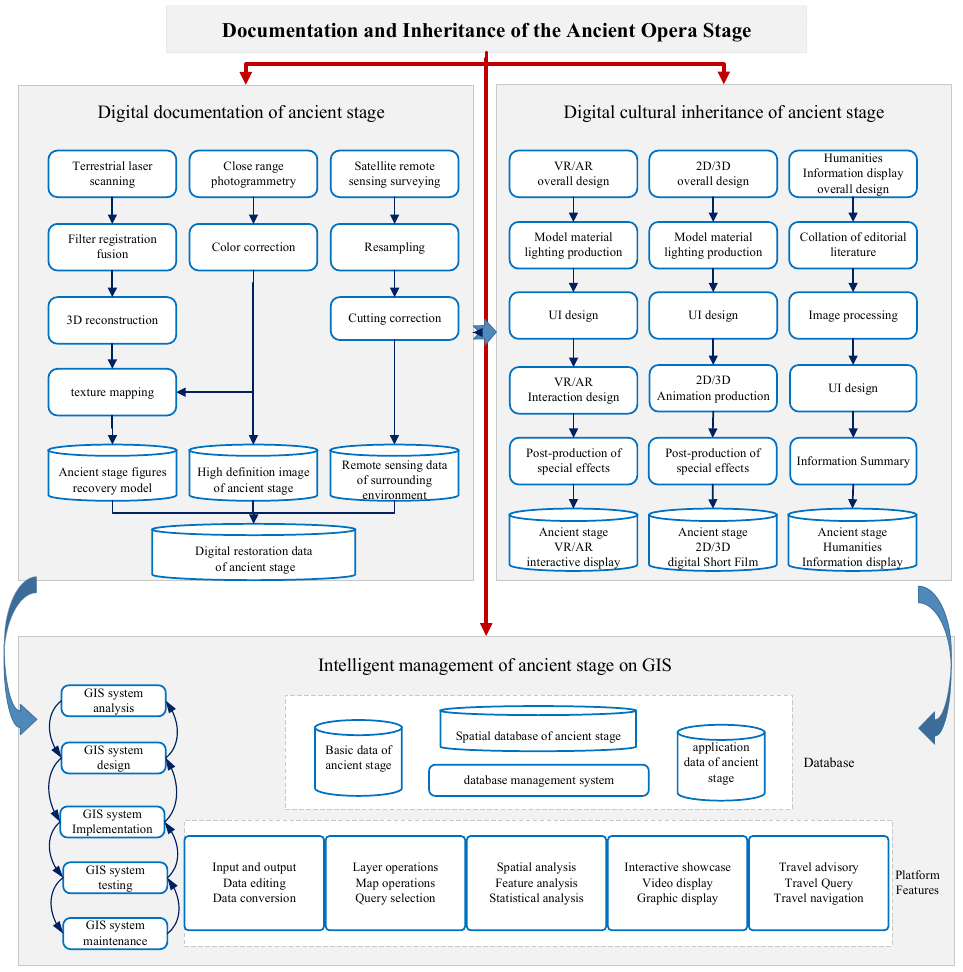
Figure 1. Technical flowchart.